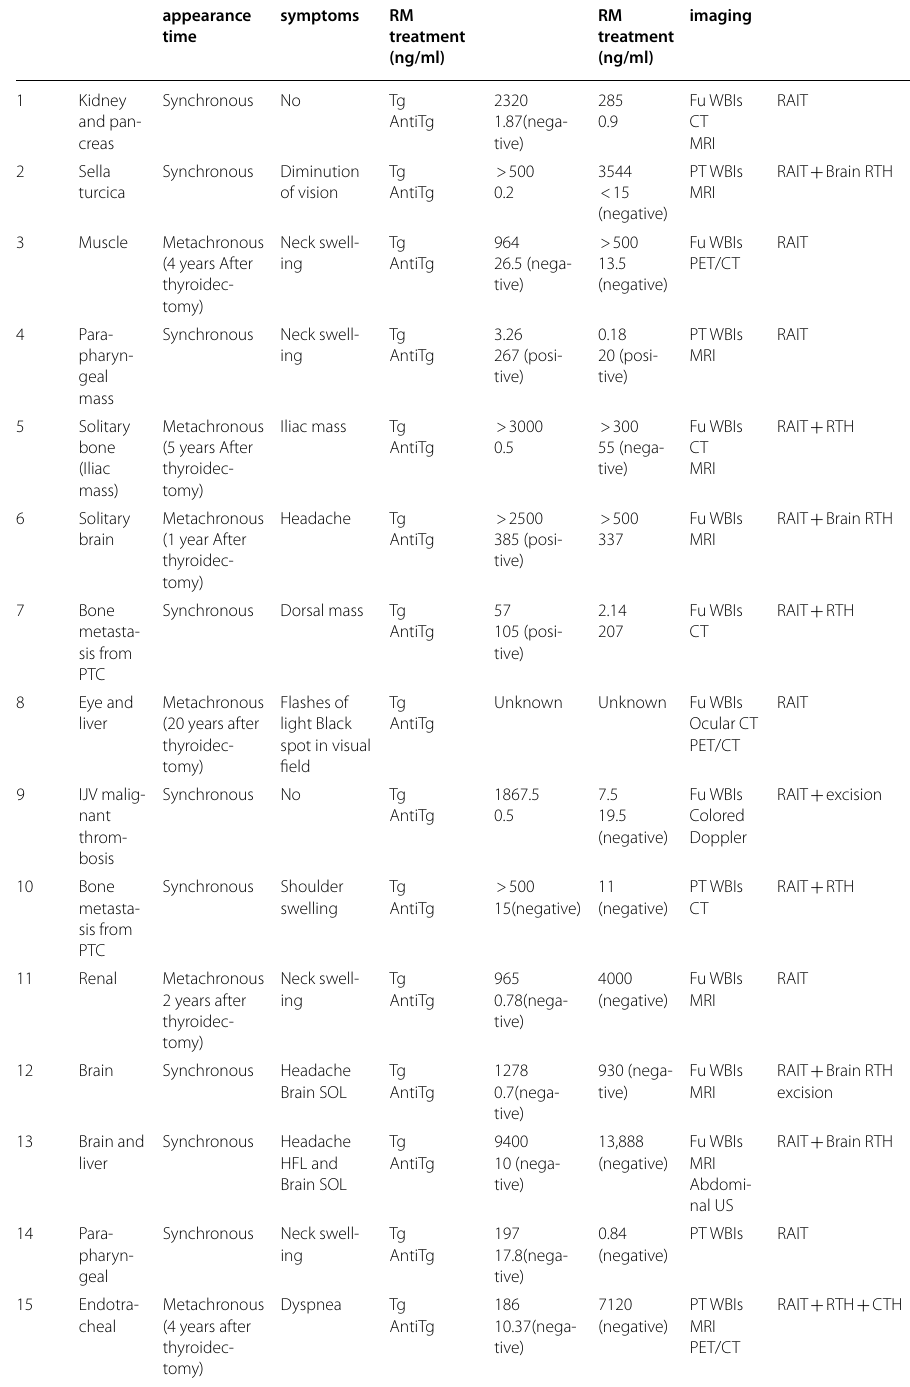
RM rare metastasis, TM tumor marker, Tg Thyroglobulin, AntiTg anti-thyroglobulin antibodies, Fu WBIs follow-up whole body iodine-131 scan, PT WBIs post-therapy whole body iodine-131 scan, RAIT radioactive iodine-131 therapy, RTH